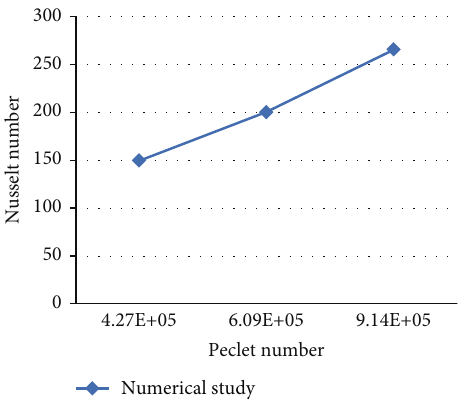
Figure 10: E ff ect of friction factor with Reynolds number for 1% alumina.